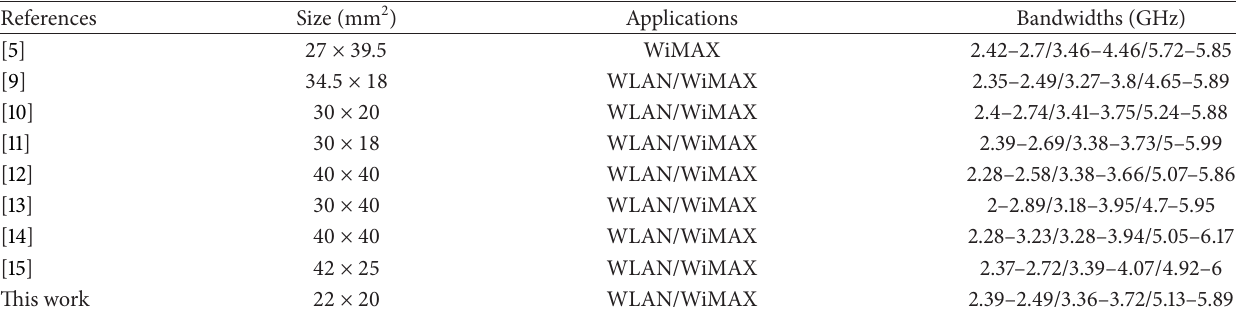
Table 1: Comparison of the proposed triband antenna with some reported